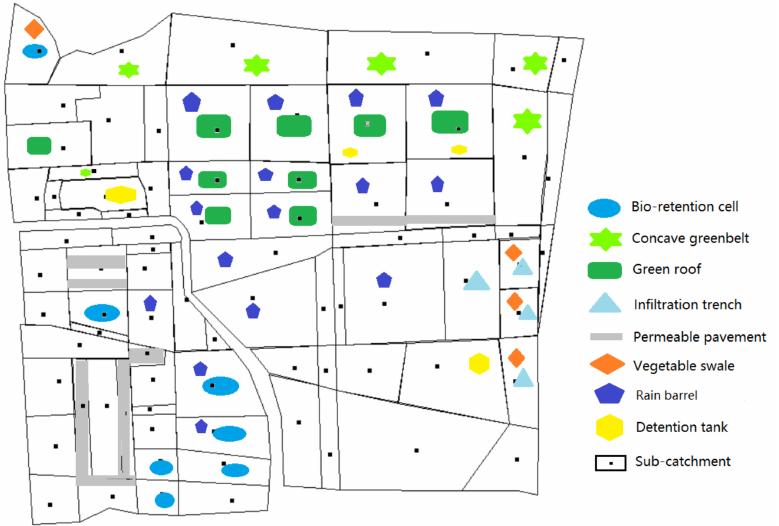
Figure 4. Illustration of the distribution of LID facilities.